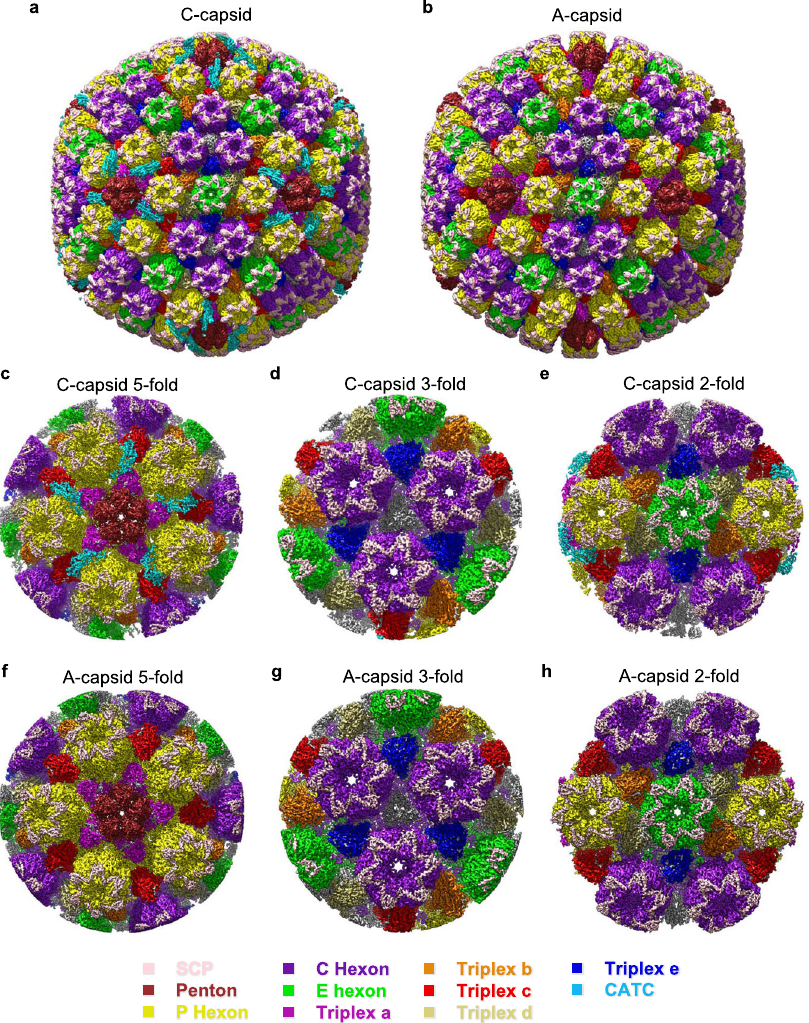
Fig. 1 Icosahedral and sub-particle reconstructions of PRV C- and A-capsids. a , b Shaded-surface representations of the PRV C-capsid ( a ) and A-capsid ( b ) revealing the presence of capsid-associated tegument complexes (CATCs) on the C-capsid. c – e Reconstructions for sub-particles extracted for the 5-fold ( c ), 3-fold ( d ), and 2-fold ( e ) of the C-capsid, respectively. f – h Reconstructions for sub-particles extracted for the 5-fold ( f ), 3-fold ( g ), and 2-fold ( h ) of the A-capsid,